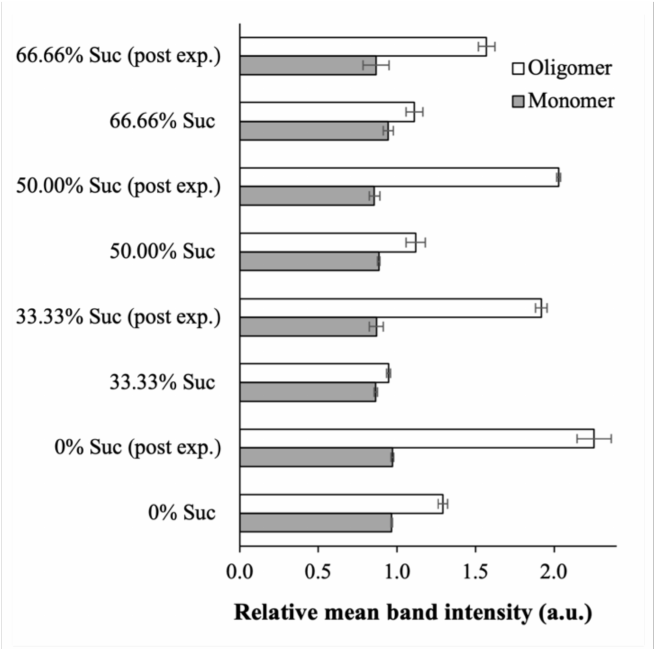
Figure 8. Relative mean intensities of the protein bands of the lyophilized nanoplexes prepared at different sucrose mass fractions before and after the 30-day exposures. The relative mean intensities were calculated with respect to the band intensity of the raw BSA (“post exp.”: